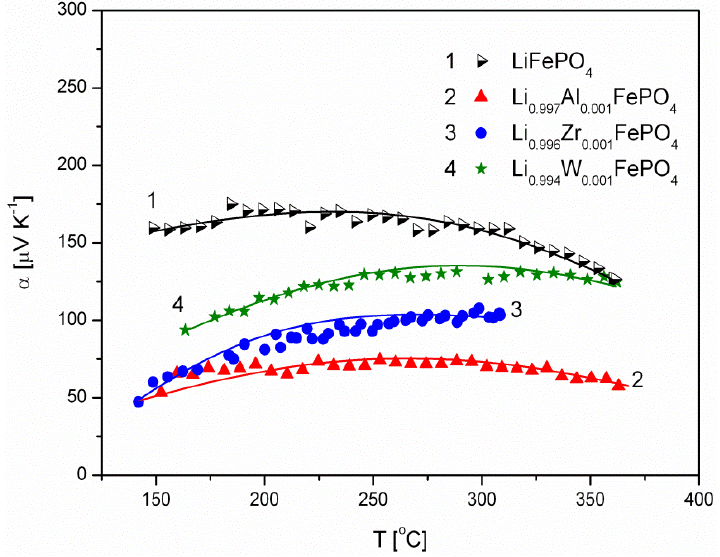
Figure 9. Temperature dependence of thermoelectric power of Li-site substituted phosphoolivines with x = 0.001 mol mol − 1